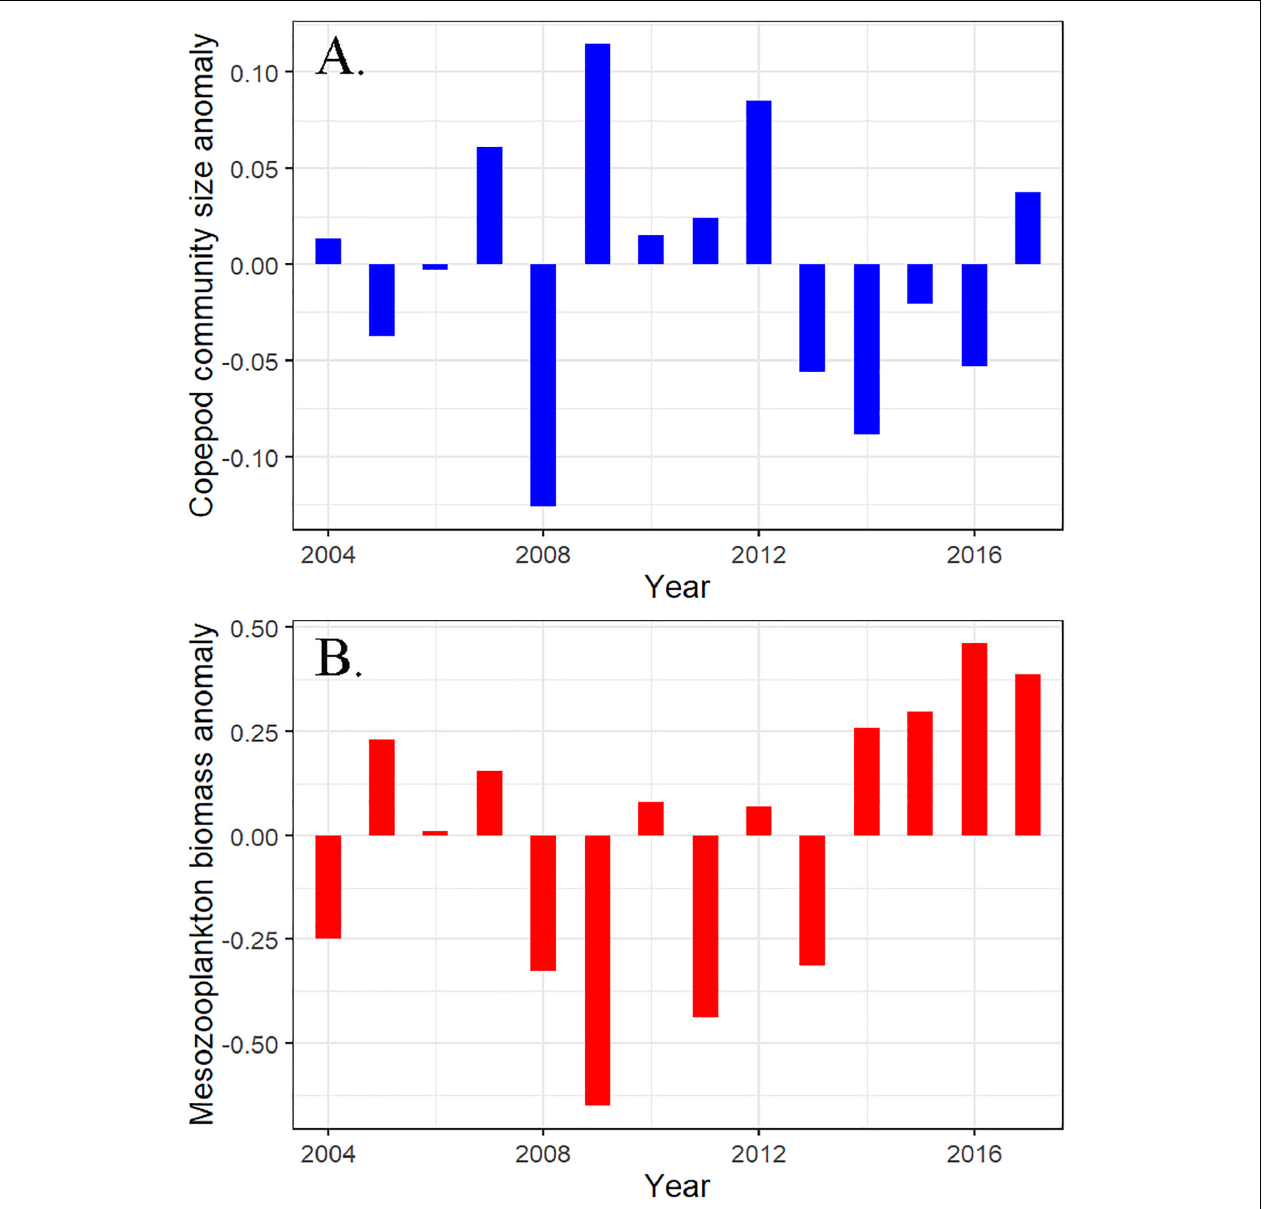
FIGURE 10 | Gulf of Alaska (A) copepod community size anomaly and (B) mesozooplankton biomass anomaly. Data for this figure were from Batten